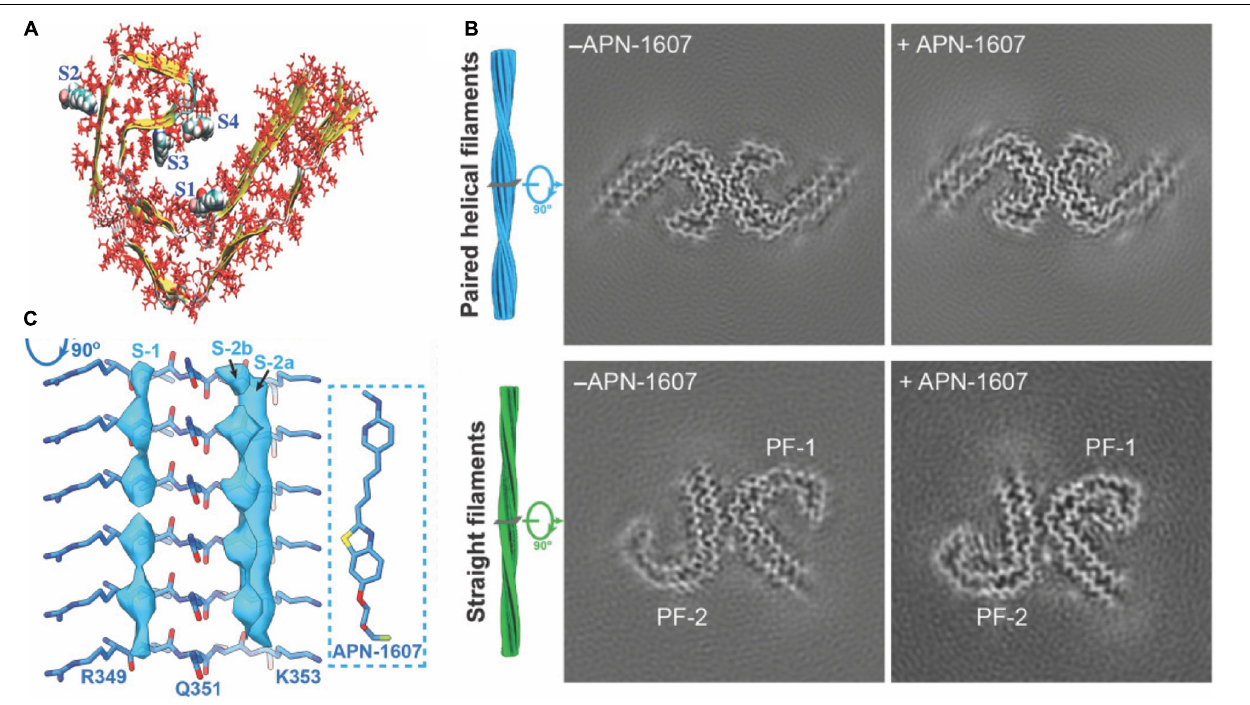
FIGURE 1 | Structural and binding properties of the tau protein. (A) Side view of [ 18 F]PM-PBB3 binding to straight filaments in AD. (B) Images from cryo-EM showing paired helical filaments and straight filaments in AD with bound [ 18 F]PM-PBB3 (+APN-1607) and without [ 18 F]PM-PBB3 (–APN-1607). Reproduced from Shi et al. (2021b) with permission from Springer Nature. (C) Chemical structure of a tau protofibril, representing the four high-affinity binding sites for tau tracers. S1, S3, and S4 show the core sites, and S2 shows the surface site. Reproduced from Murugan et al. (2018) with permission from American Chemical